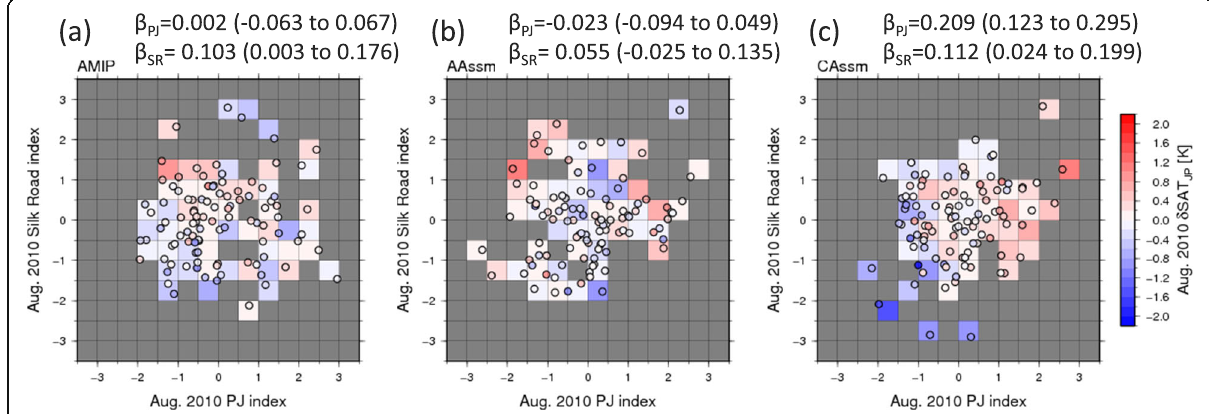
Fig. 7 Multiple linear regression of SAT JP anomalies against PJ and Silk Road pattern indices for August 2010 from a AMIP, b AAssm, and c CAssm experiments. β PJ and β SR are the regression coefficients of PJ and Silk Road pattern indices with 95% confidence intervals as the numbers within parentheses,